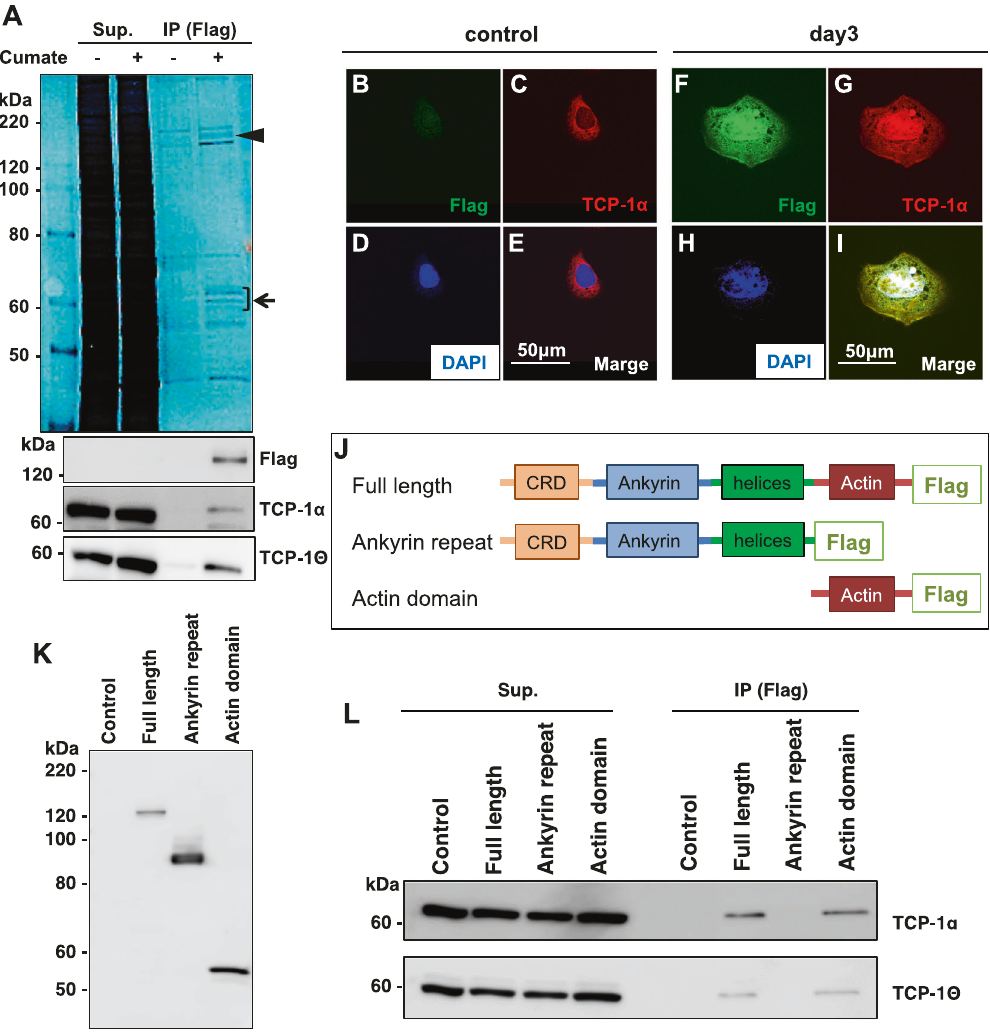
Fig. 3 POTEF interacts with CCT subunits through its own actin domain. A Co-immunoprecipitants with anti-Flag antibody were separated on SDS-PAGE and visualized using Negative Gel Stain MS Kit. The band around 120 kDa (arrowhead) was subsequently con fi rmed as POTEF with western blotting. Other unique bands visualized around 60 kDa (arrow) were identi fi ed with mass spectrometry (Supplementary Table 2). Two CCT subunits were con fi rmed as molecules interacting with POTEF using both anti-TCP-1 α and anti-TCP-1 θ antibodies. B – D Fluorescent image of CuO-POTEF-Flag HGrC1 cells with anti-Flag antibodies, anti-TCP-1 α antibodies, or DAPI nuclear staining, respectively, without cumate treatment. E Merged image of ( B ), ( C ), and ( D ). F – H Fluorescent image of CuO-POTEF-Flag HGrC1 cells with anti-Flag antibodies, anti-TCP-1 α antibodies, or DAPI nuclear staining, respectively, after 3 days in the presence of cumate solution. I Merged image of ( F ), ( G ), and ( H ). Scale bars, 50 µm. J Schematic comparison of human POTEF based on the immunoprecipitation experiments. Full-length POTEF has a cysteine-rich domain (CRD, orange), ankyrin repeat (Ankyrin, blue), helices domain (helices, green), actin domain (Actin, red), and Flag tag at the C-terminus. The ankyrin repeat consisted of full-length POTEF without the actin domain. The actin domain consisted of only the actin domain. K Immunoprecipitation with anti-Flag antibody followed by western blotting with anti-Flag antibody. L Co-Immunoprecipitation with anti- Flag antibody followed by western blotting with anti-TCP-1 α and anti-TCP-1 θ blotting. Regarding the bands around 60 kDa (arrow in Fig. 3A), Identi fi cation of molecules interacting with POTEF in mass spectrometry detected the subunits of CCT (Supplementary HGrC1 cells Table 2) The IP-western blot with antibodies against each subunit POTEF and POTEE each contain four domains, including an actin of CCT, anti-TCP-1 α and anti – TCP-1 θ , indicated that POTEF domain (Fig. 3J) [18]. However, the functions of each domain are interacts with CCT subunits (Fig. 3A). unknown. To date, molecules that directly interact with POTEF To con fi rm whether CCT interacts with POTEF in HGrC1 cells, we protein have not been reported. Hence, to assess the molecular performed fl uorescent staining of CuO-POTEF-Flag HGrC1 cells role of POTEF in the suppression of cell proliferation, we using an anti-TCP-1 α antibody. When POTEF was not expressed, performed IP using an anti-DDDDK antibody to identify molecules TCP-1 α was localized to the cytoplasm around the nucleus interacting with POTEF. SDS-polyacrylamide gel electrophoresis (Fig. 3B – E). This result was consistent with the previous report (SDS-PAGE) staining identi fi ed several bands around 120 and that CCT is associated with the cytoplasmic aspect of membranes 60 kDa, respectively (Fig. 3A). The 120-kDa molecule (arrowhead in of the trans-Golgi network [22]. With chemical induction, POTEF Fig. 3A) was subsequently con fi rmed to be POTEF with western